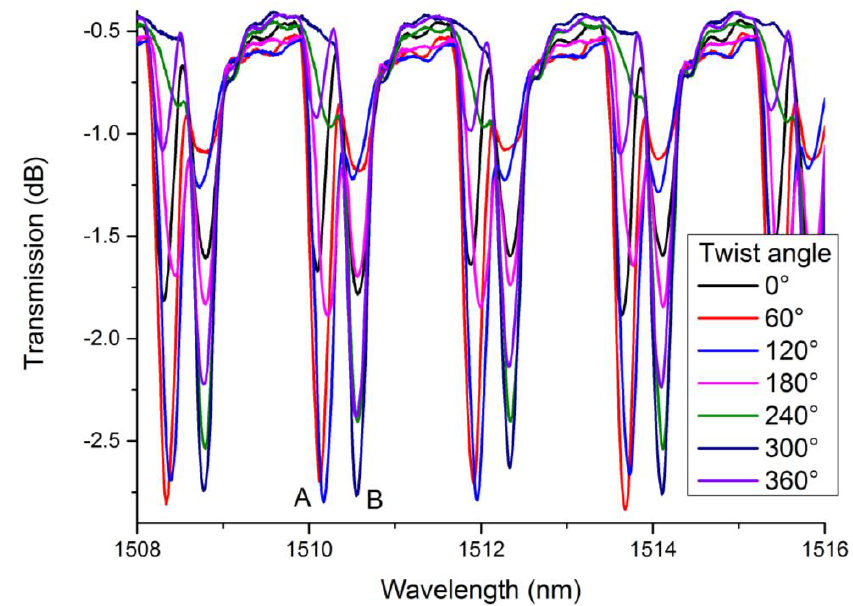
Figure 8. Spectra of 18°TFBG under different twist angles.